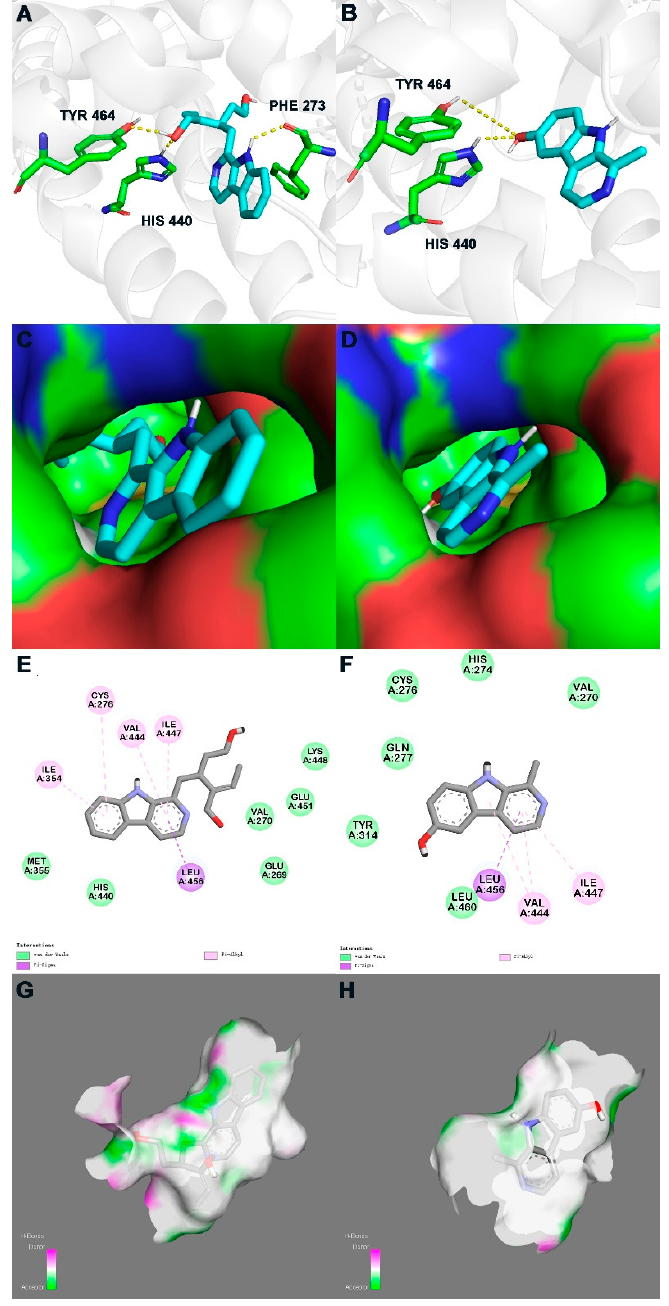
Figure 3. In silico binding mode of 2 and 3 at PPAR α crystal structure 5HYK: first row—the trans- parent protein surface, in light grey color, and two compounds shown as sticks with atoms colored C cyan, N blue, O red, and H white, are shown to emphasize the clear combination of hydrogen bonds within the target pocket; second row—surfaces of 5HYK with combined compounds; third row—two-dimensional ligand interaction diagrams of two compounds at the PPAR α domain; fourth row—receptor surface of H-bond. Left list ( A , C , E , G ) represents docking results of 2 ; Right list ( B , D , F , H ) represents docking results of 3 . Table 2. In silico molecular docking binding affinities of compounds 2 and 3 to PPAR α crystal structure (PDB: 5HYK).